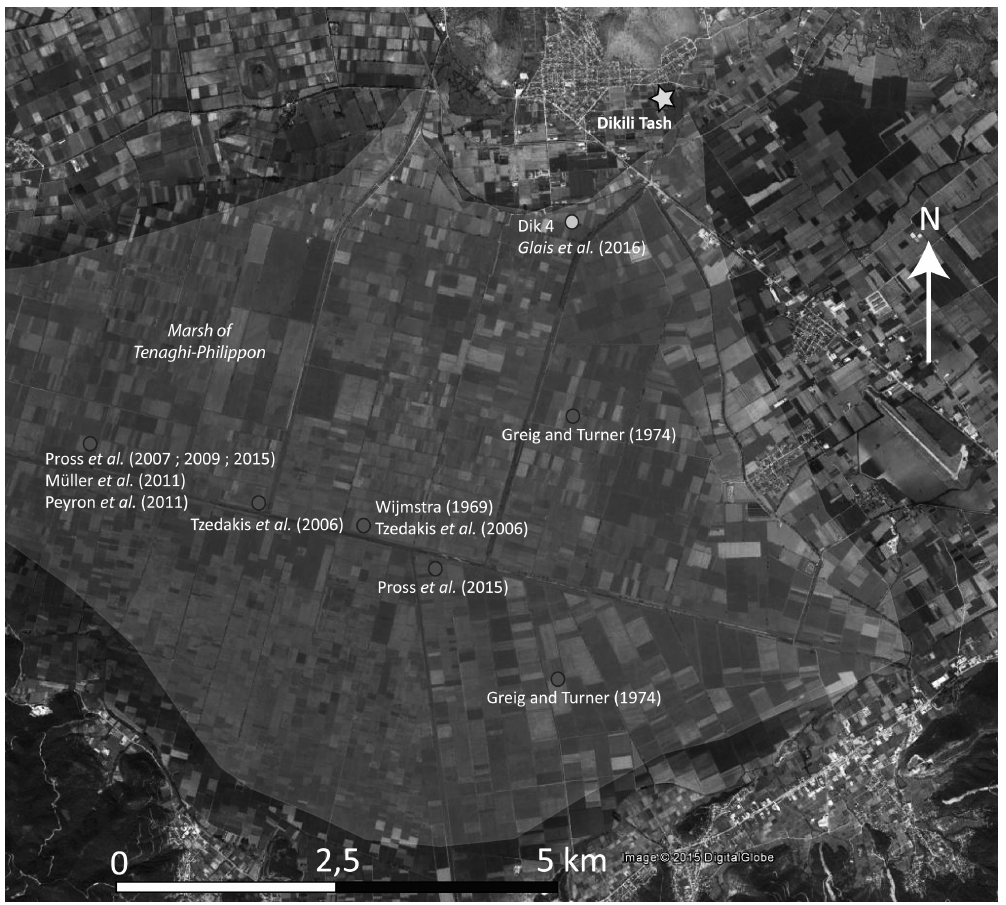
Figure 6. The Tenaghi Philippon (former) marsh, Dikili Tash archaeological sites and sample cores obtained from the marsh deposits mentioned in the references. Image from Google Earth (40 ◦ 58 (cid:48) 0N, 24 ◦ 15 (cid:48)